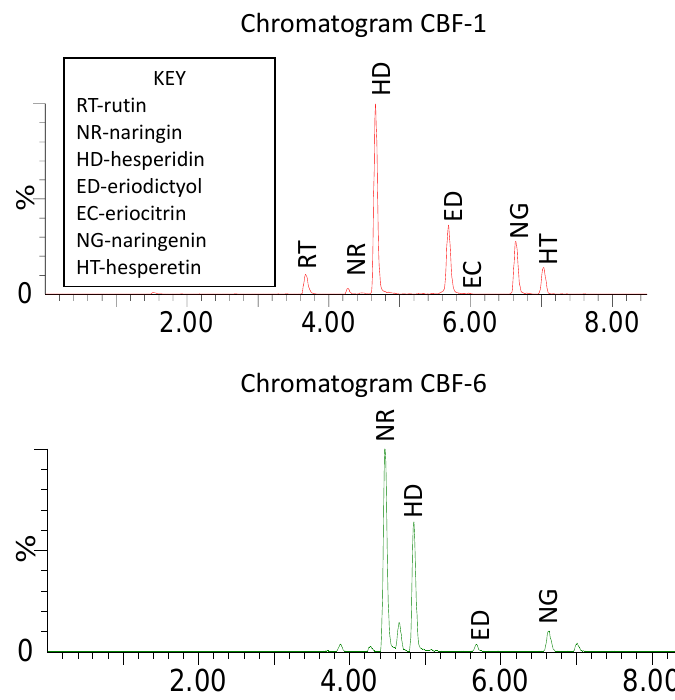
Figure 2. Example chromatograms of supplements CBF-1 and CBF-6, showing bioflavonoid peaks. Figure 1 - Example chromatograms of supplements CBF-1 and CBF-6 showing bioflavonoid 4 peaks. 5 Table 3 details the flavonoid profile of each supplement, determined by UPLC–MS/MS analysis, expressed as % w / w of each flavonoid analysed in the supplement extract, with respect to the total flavonoid content. The final column of Table 3 describes the total flavonoid content of each supplement expressed as the % w / w of flavonoids with respect to the supplement